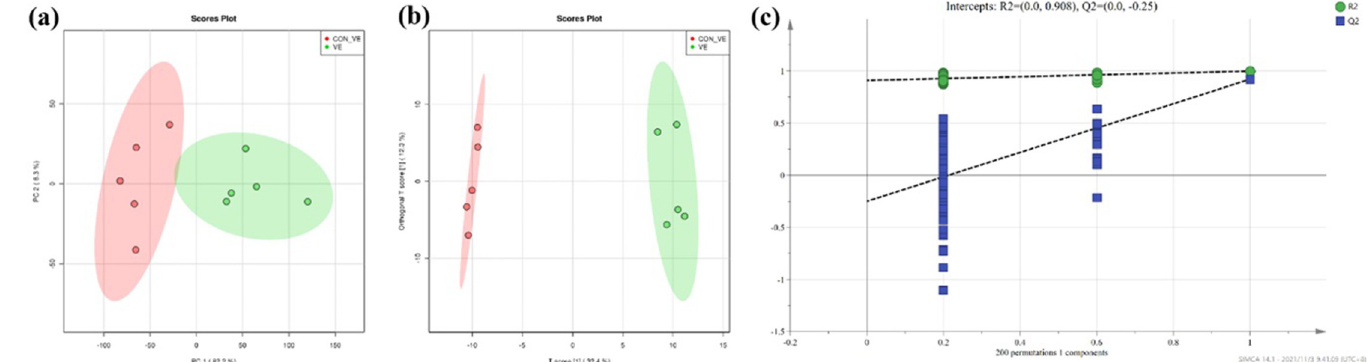
Fig 4. Metabolomics of PCA analysis with serum sample before and after VE injection after transportation in yak. (a), OPLS-DA analysis (b) and permutation test of OPLA-DA (c). CON_VE = blood sample was collected once upon arriving the farm before injection.VE = blood sample was collected after injection on the 10 th day. PCA = principal component analysis, the red represent CON_VE, and the green represent VE injection. OPLS-DA = orthogonal partial least squares discriminant analysis, the red represent CON_VE, and the green represent VE injection.